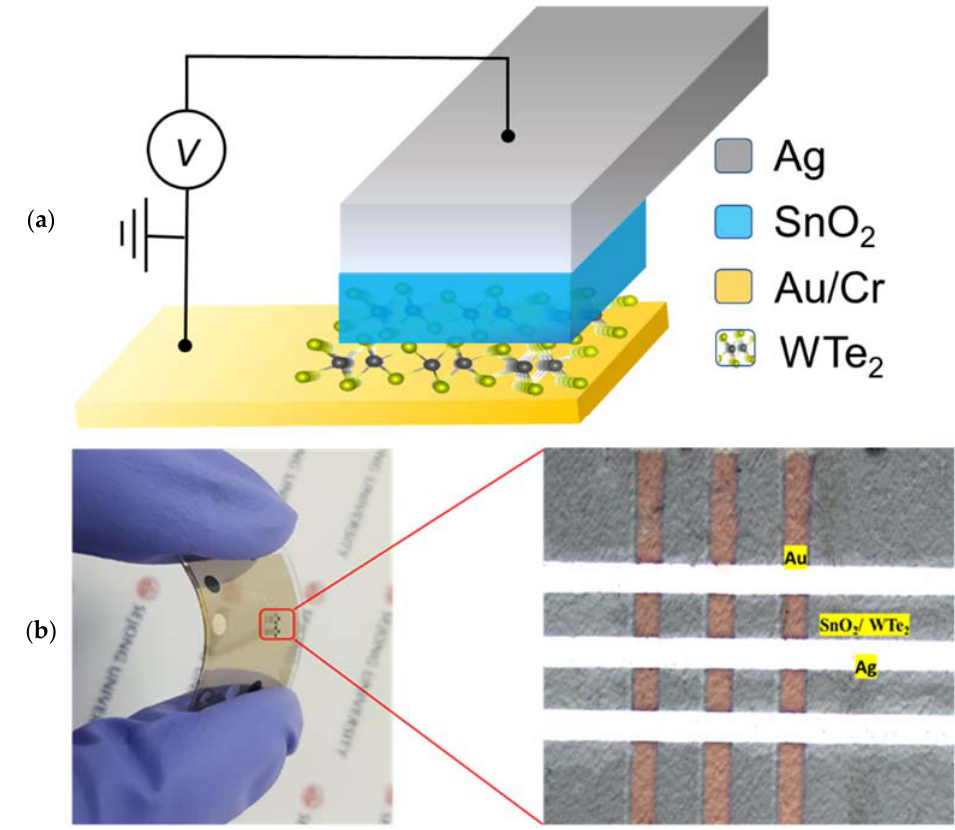
Figure 1. ( a ) Schematic illustration of the resistive-switching devices composed of bilayer SnO 2 /WTe 2 sandwiched between Ag and Au metal electrodes. Measurement geometry of the electrical connections is also shown for memristive behavior. ( b ) The optical image of the memristive device is also illustrated and marked with yellow boxes.